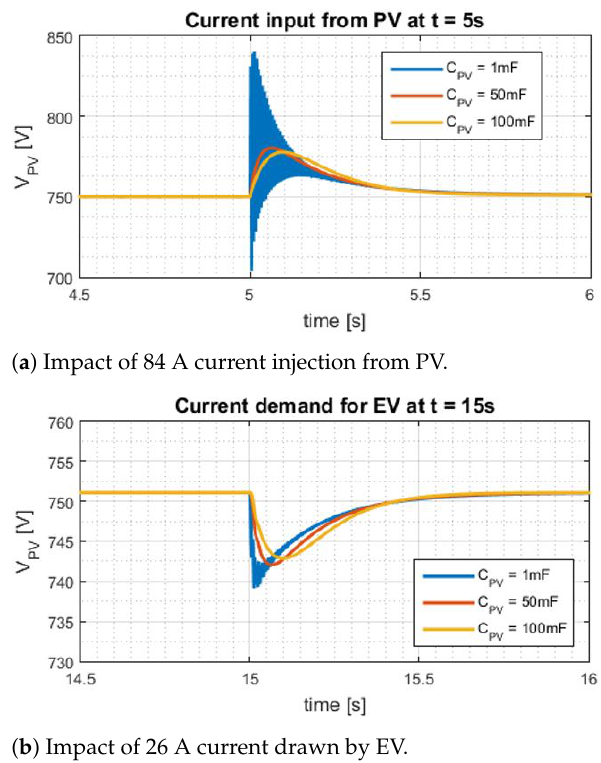
Figure 13. PV side voltage of DC nanogrid due to power mismatches.